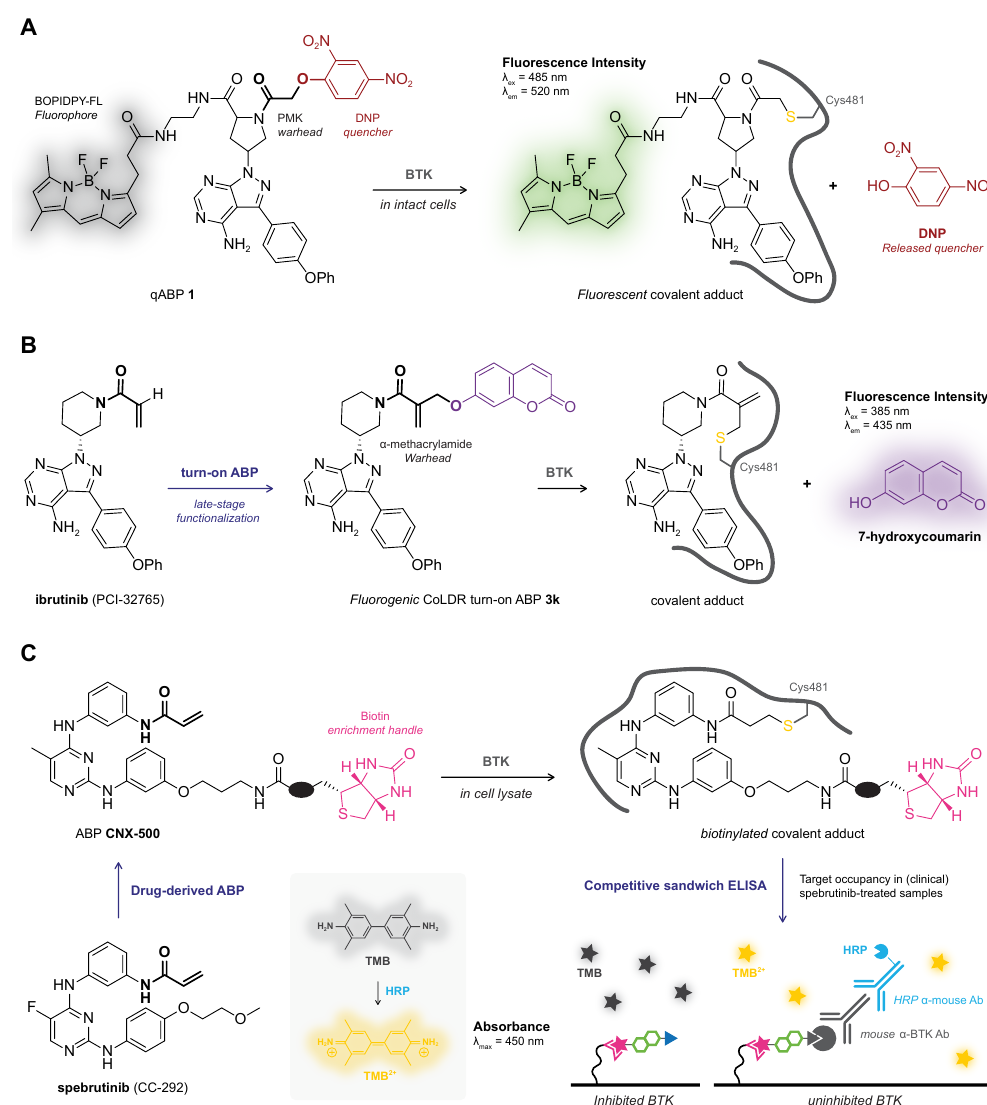
Figure 12. Homogeneous (plate-based) approaches to detect covalent adduct formation with drug-derived ABPs. ( A ) Quenched fluorescent ABP (qABP) with a recognition element based on the ibrutinib scaffold to selectively target BTK [252]. The DNP (2,4-dinitrophenyl) quencher is expelled upon covalent adduct formation, enabling fluorescence detection of the BODIPY-FL fluorophore in the covalent adduct but not in unbound or noncovalently bound qABP. ( B ) Covalent ligand directed release (CoLDR) chemistry to generate turn-on fluorogenic ABPs [255]. Adduct formation of ibrutinib-derived turn-on fluorogenic ABP 3k with BTK is monitored by fluorescence intensity as thiol addition to the substituted α -methacrylamide warhead results in release of fluorescent 7-hydroxycoumarin. ( C ) Quantification of cellular BTK occupancy in a competitive ELISA (enzyme-linked immunosorbent assay) experiment [262]. Spebrutinib-treated lysates originating from tissue (culture) or clinical samples are incubated with biotinylated ABP CNX-500 to detect free, uninhibited BTK. Biotinylated BTK–ABP adducts are captured on a streptavidin-coated ELISA plate, treated with primary mouse α -BTK Ab and secondary HRP anti-mouse Ab, and developed by addition of HRP substrate tetramethyl benzidine (TMB). Uninhibited BTK is quantified from the concentration of the yellow HRP product TMB 2+ , with calculation of inhibitor occupancy from the OD 450 in the treated samples relative to the untreated